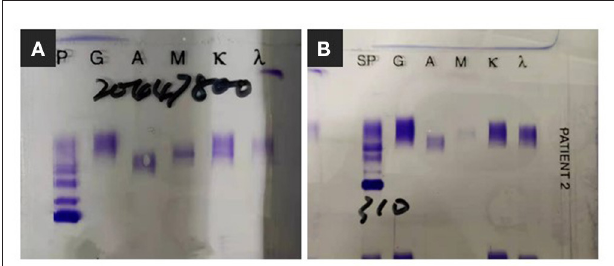
FIGURE 2 | Immunofixation electrophoresis findings. (A) Monoclonal IgM κ in the serum. (B) Monoclonal band was not detected since clinical complete remission.